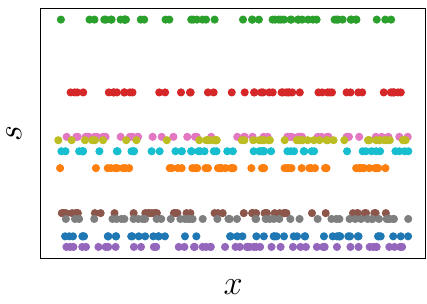
Figure 1 . Illustration of the sampling in s – x space. For independent numerical integrations each line of different color corresponds to an individual integration and no information is pooled between them.